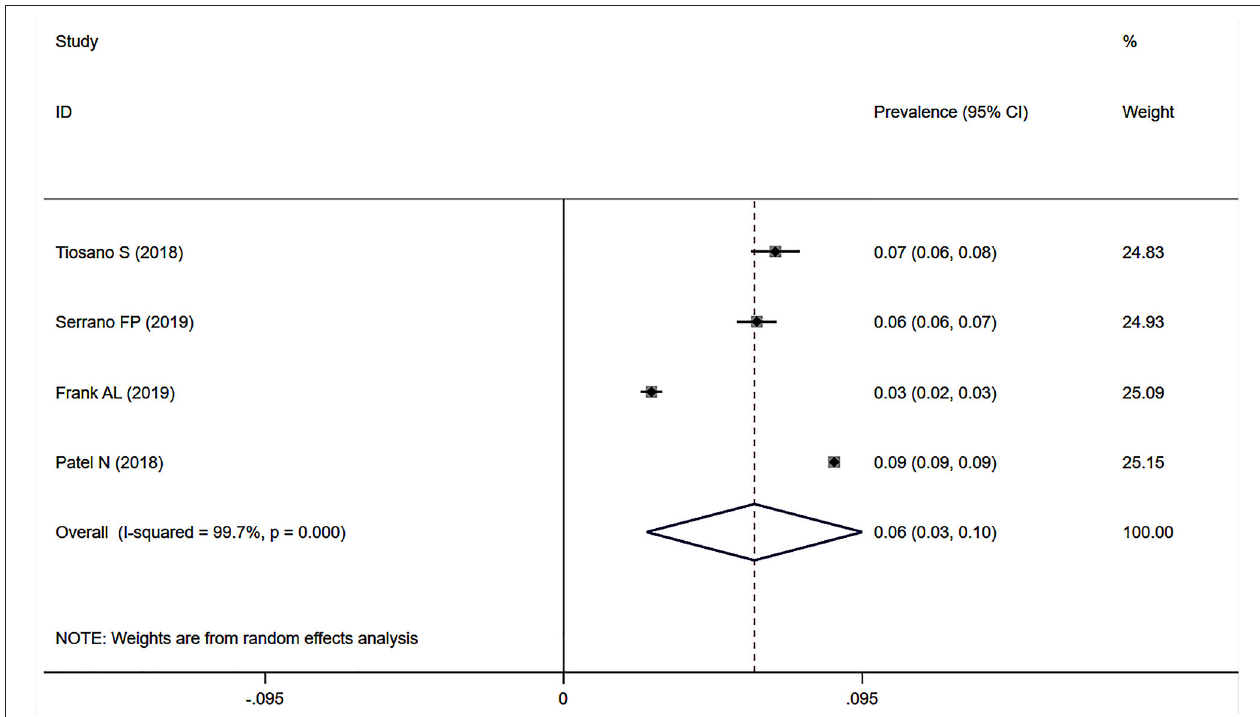
FIGURE 8 | Forest plot of the pooled prevalence of SAPH in large databases with documented diagnoses. SAPH, sarcoidosis-associated pulmonary hypertension.